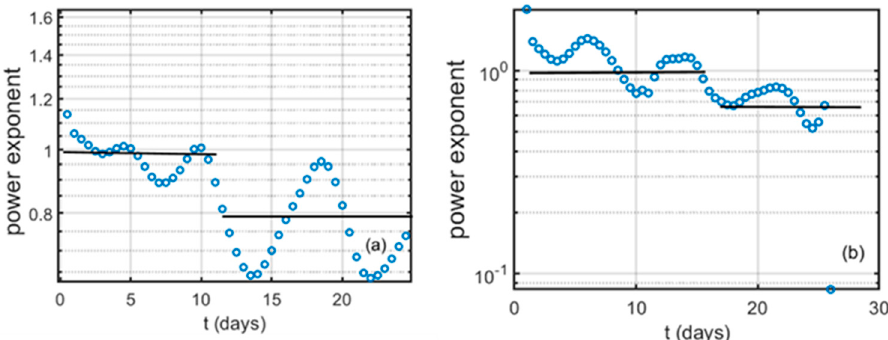
Figure 8. Power exponents (blue dots) for float #73 ( a ) and #109 ( b ). Black solid lines show derived power exponents.